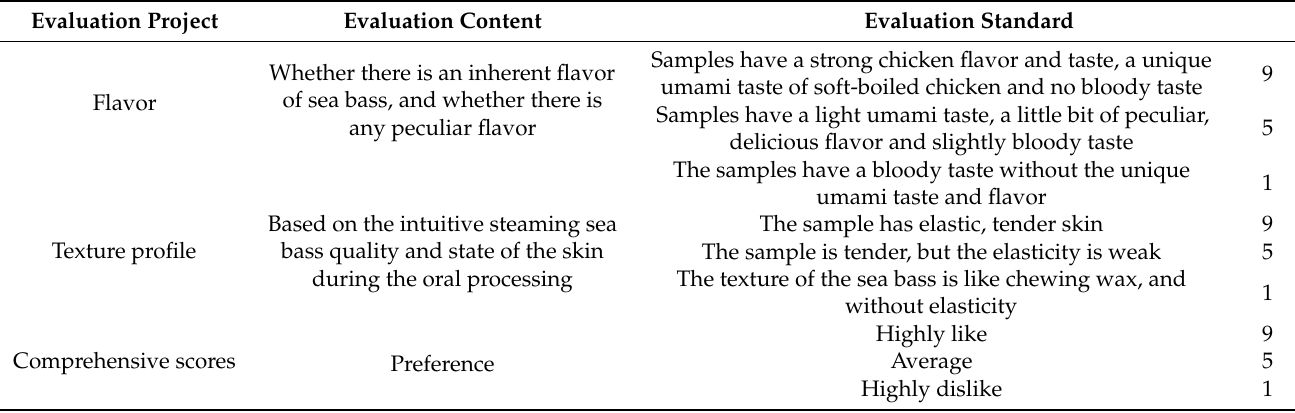
Table 4. Sensory evaluation standard for steaming sea